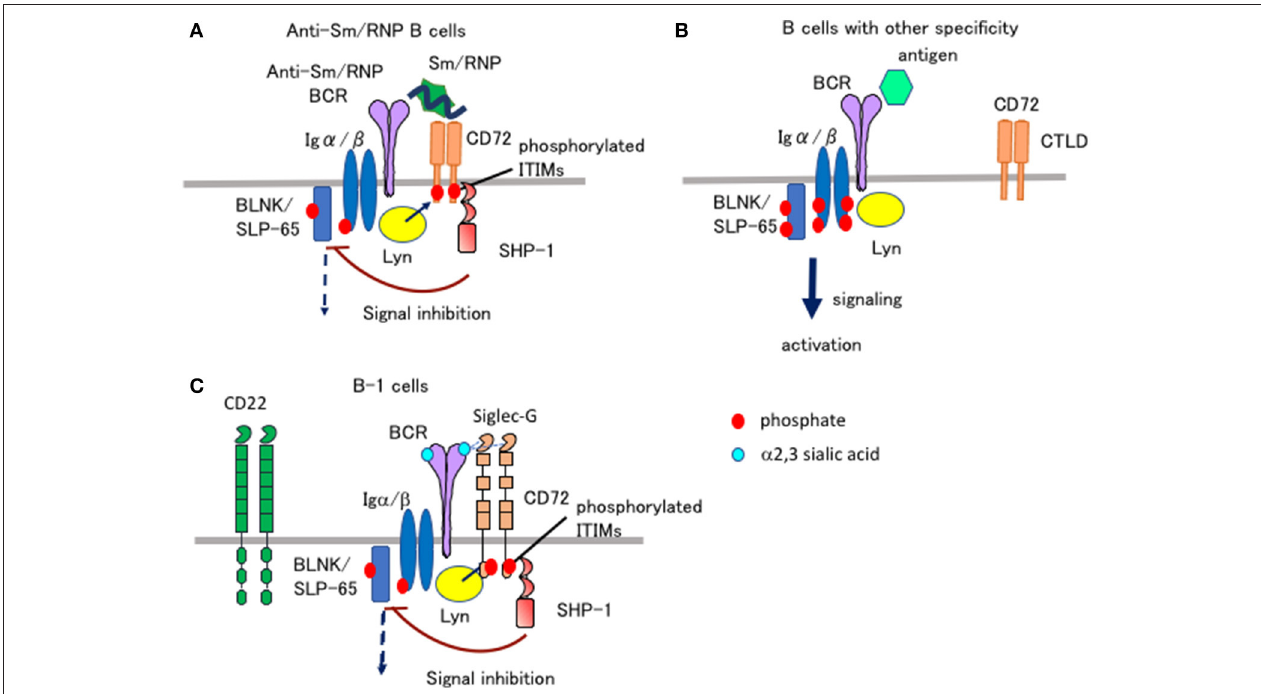
FIGURE 2 | Ligand recognition determines the functional properties of CD72 and Siglec-G. (A,B) CD72 specifically inhibits BCR signaling in Sm/RNP-reactive B cells by recognizing Sm/RNP as a ligand. When Sm/RNP interacts with Sm/RNP-reactive BCR, CD72 is recruited to BCR by recognition of Sm/RNP (A) . CD72 ITIM is then phosphorylated by Lyn and recruits SHP-1. This leads to suppression of BCR signaling in Sm/RNP-reactive B cells thereby inhibiting production of anti-Sm/RNP antibody crucial for development of lupus. When other antigens that do not bind to CD72 interact with BCR, CD72 is kept away from BCR and does not inhibit BCR signaling (B) . (C) Siglec-G inhibits BCR signaling in B-1 cells by recognizing α 2,3 sialic acid as a ligand. Because glycoproteins in B-1 cells are dominantly glycosylated with α 2,3 sialic acid, Siglec-G constitutively associates with BCR by recognizing α 2,3 sialic acid expressed on BCR in B-1 cells,